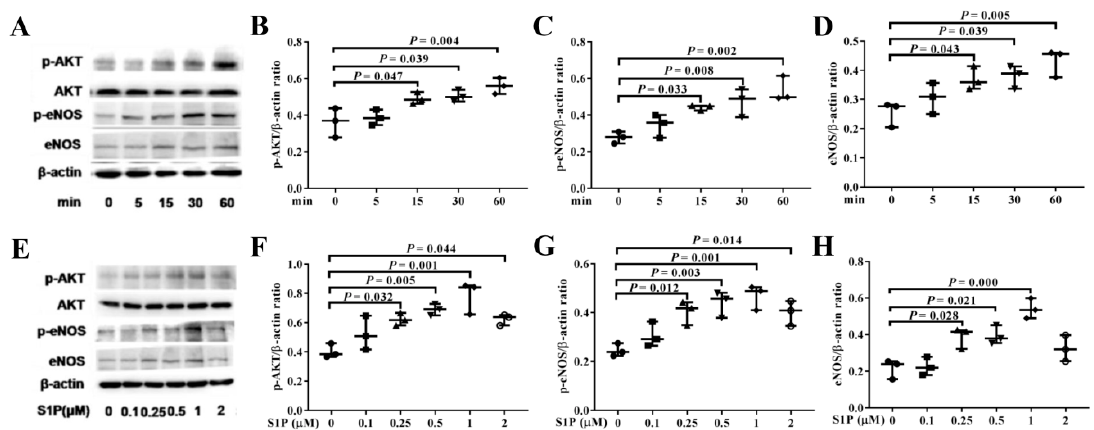
Figure 4. S1P up-regulates the levels of phosphorylated AKT (p-AKT), phosphorylated endothelial nitric oxide synthase (p-eNOS), and eNOS. Effects of S1P at different time duration ( A – D ) (* p < 0.05, ** p < 0.01 versus 0 min) or concentration (0–2 μ M) ( E – H ) on levels of p-AKT, p-eNOS, and eNOS in EPCs were investigated by Western blot analyses.